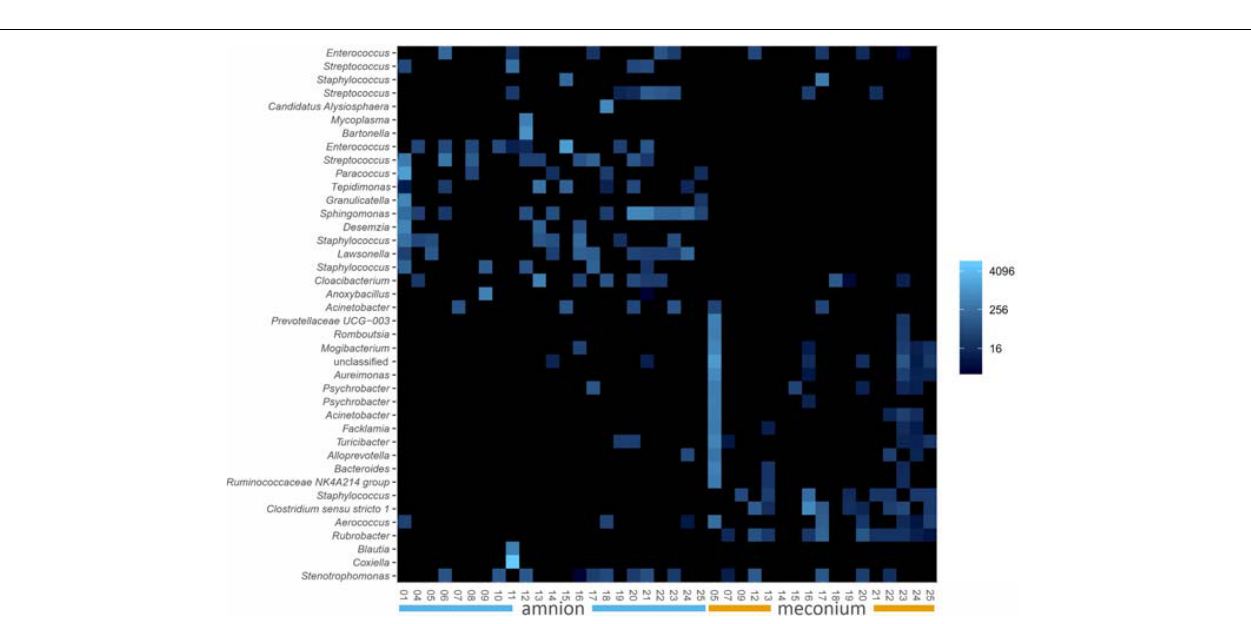
FIGURE 2 | Microbiota composition in bovine meconium and amniotic fluid samples collected during elective C-section, adult feces, and a commercial community composition standard. The main colors indicate the bacterial phyla. Within phyla, the shades indicate bacterial genera. The lightest shade of each phylum shows the combined abundance of the least abundant genera (with a maximum of < 0.5% of total).